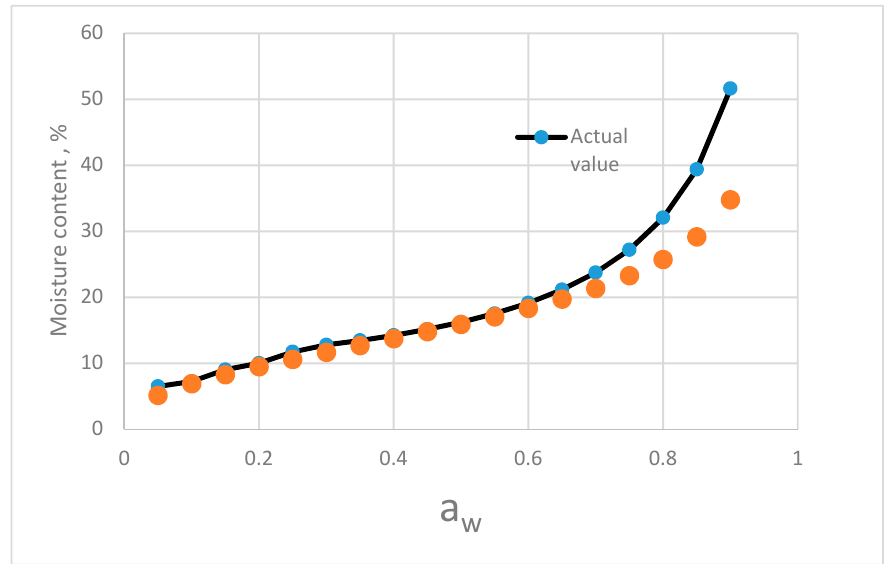
Figure 8. Comparing of the predictive values from the component model and the actual isotherm moisture of elecampe ( Inula helenium L.).